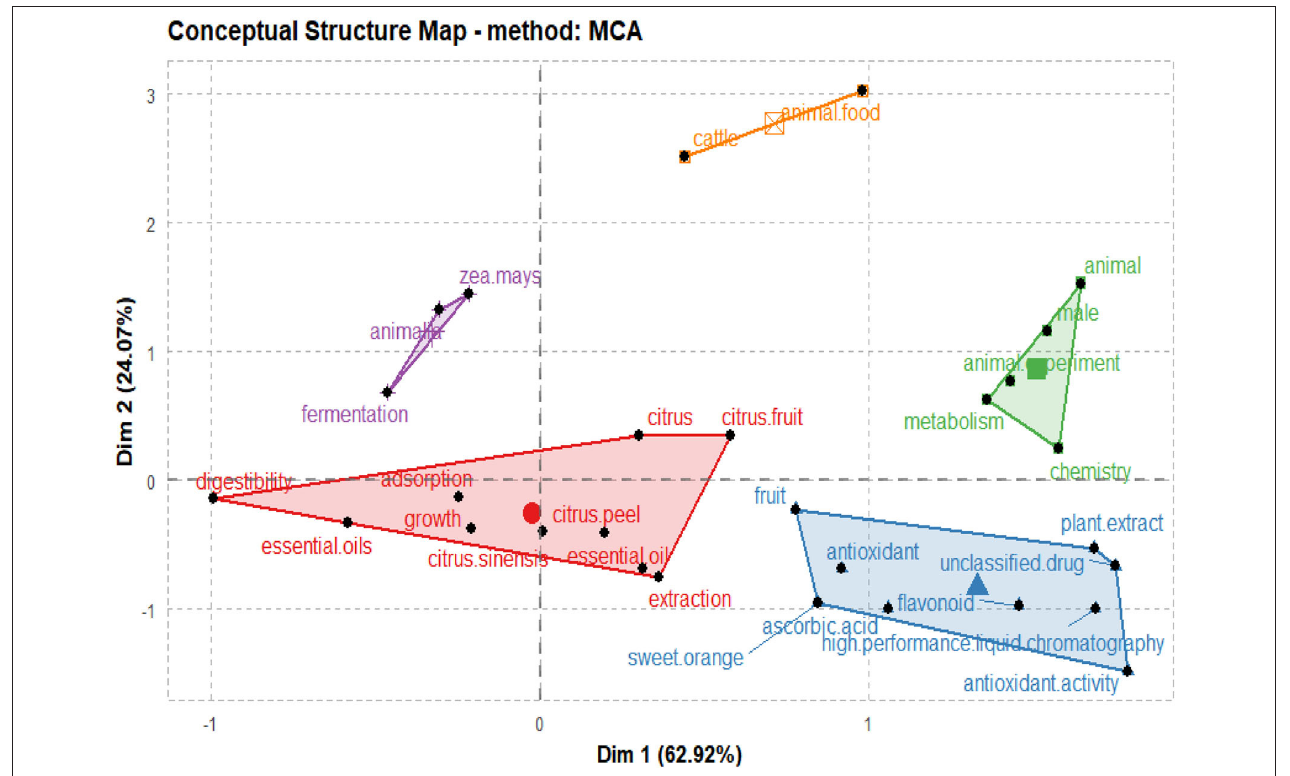
FIGURE 4 | Shared conceptual structural map associated with citrus waste and livestock feed research studies